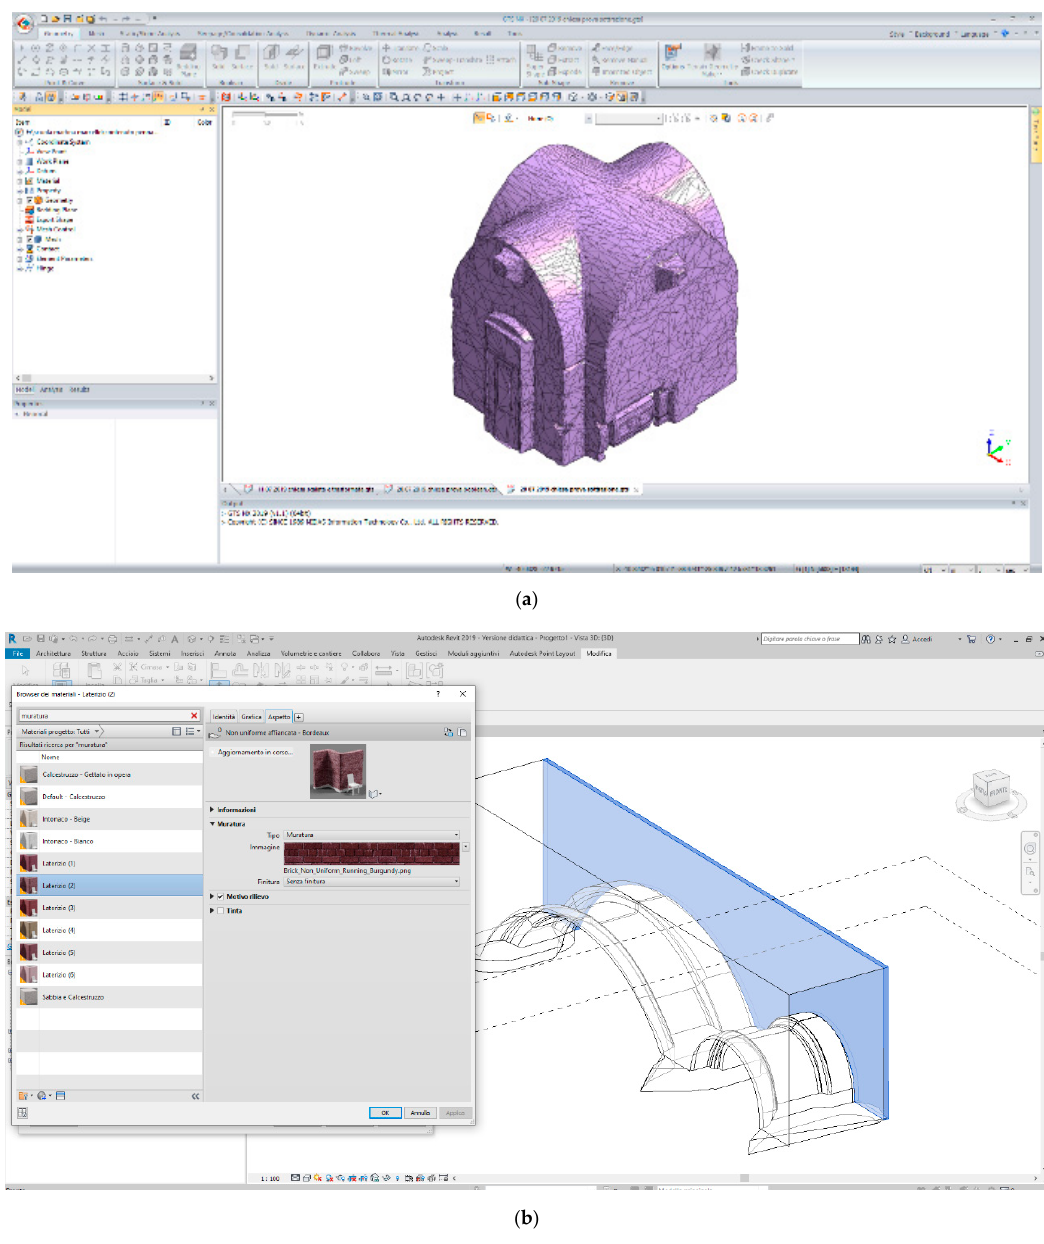
Figure 14. Visualization of the structures in Revit environment: San Nicola in Montedoro church ( a ) and San Cono masonry bridge ( b ).